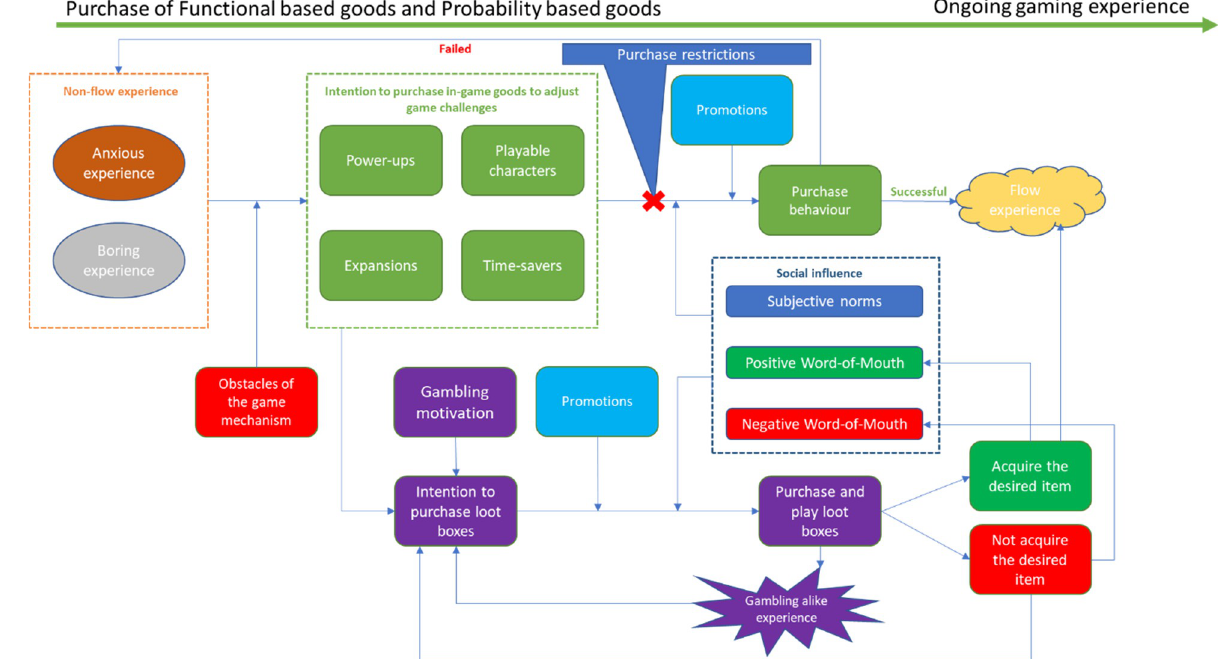
Fig 5. Purchase process between the non-flow state and actual purchase behaviour, with the existence of loot